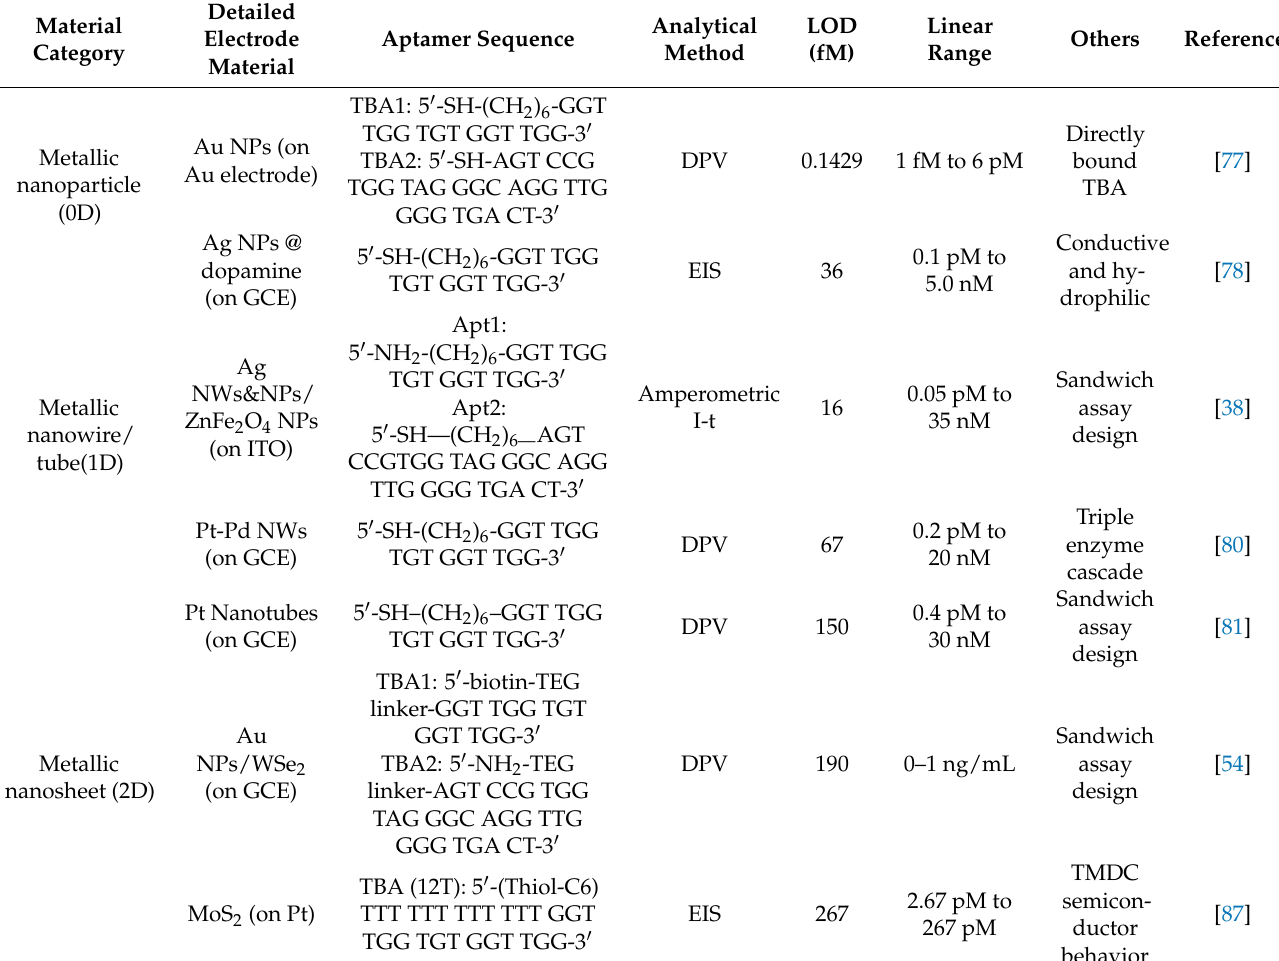
Table 1. Summary and comparison of low-dimensional metallic nanomaterials enhanced